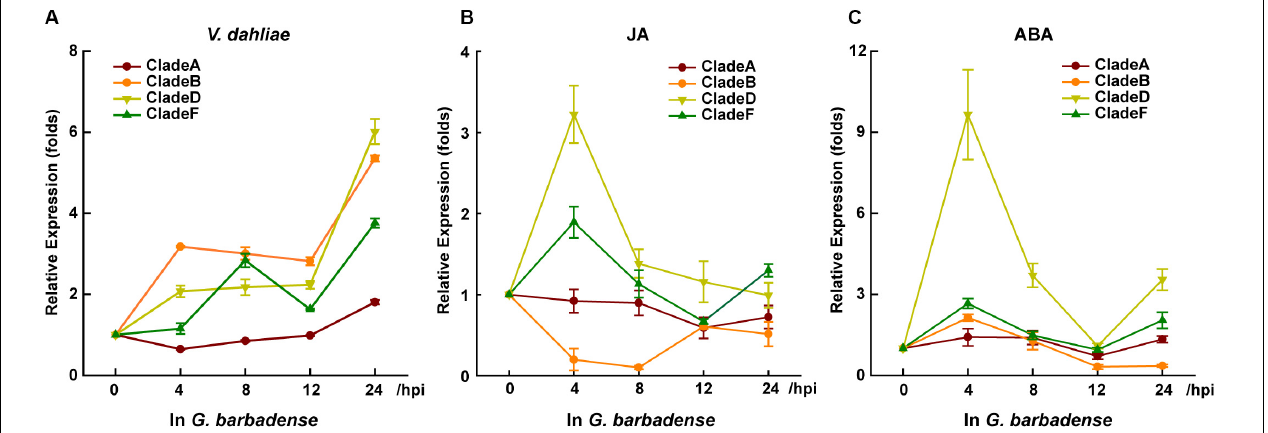
FIGURE 4 | GbRbohs in the CladeD respond to V. dahliae infection and hormones in G. barbadense . Quantitative analyses of each clade GbRbohs ’ expression levels in “Xinhai15” cotton plant leaves treated with (A) V . dahliae , (B) jasmonic acid, and (C) abscisic acid. Total RNAs were extracted from leaves of 3-week-old seedlings at 0, 4, 8, 12, and 24 h post-inoculation. The values are the mean ± SD for three technical replicates. Relative expression levels of all clade genes were determined after normalizing to the expression level at 0 h, which was set to 1.0. hpi, hours post-inoculation. The experiments were repeated at least three times, with similar